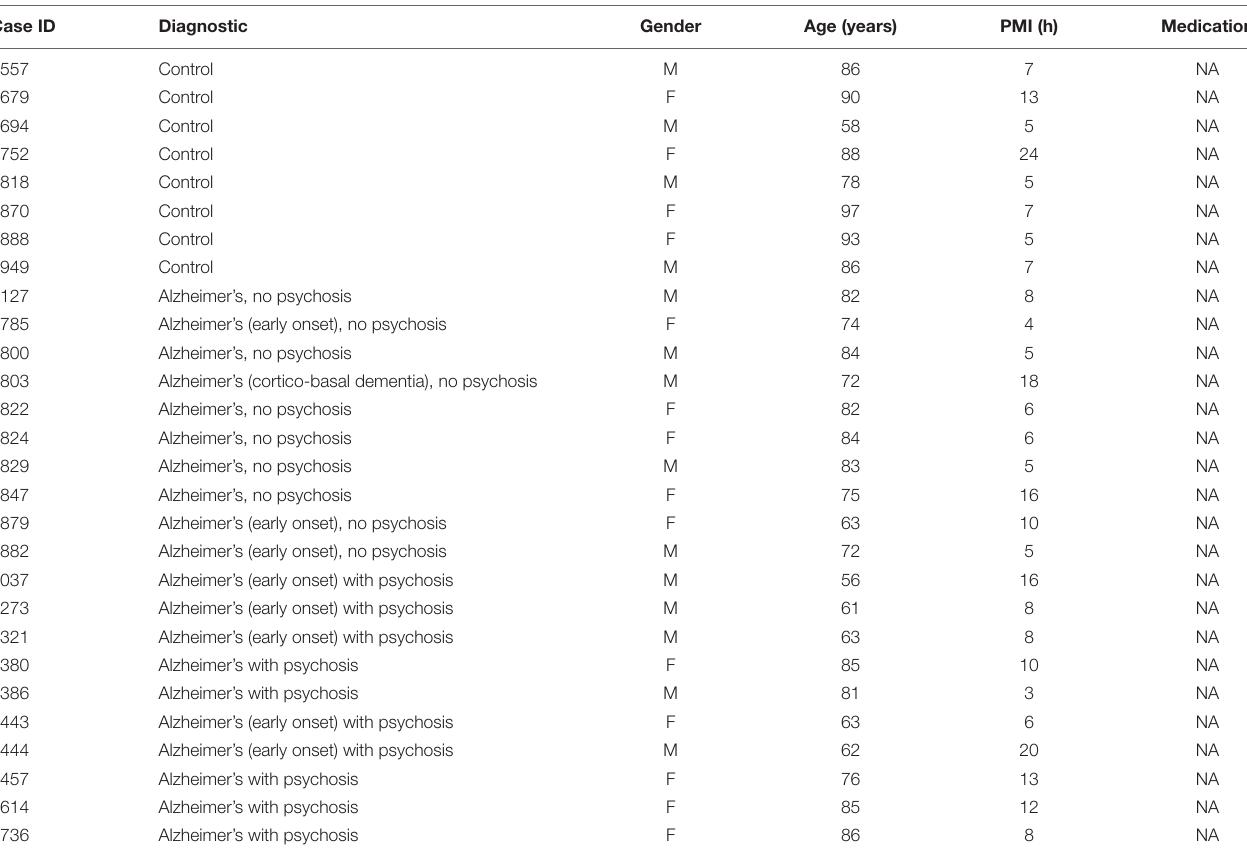
TABLE 2 | Demographics and illness details for human post-mortem hippocampal samples from patients with Alzheimer’s disease and controls. Case ID